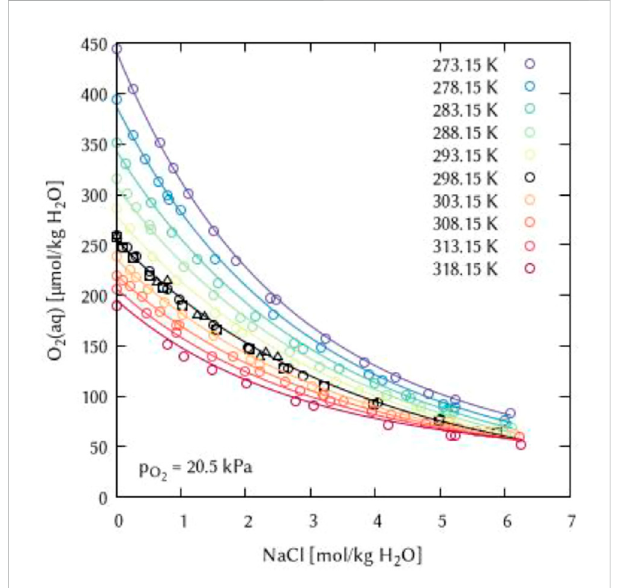
FIGURE 11 Modelling of the O 2 solubility in potassium chloride solution as a function of temperature and KCl concentration. (Points: Experimental data from □ Millero et al. (2003), Lines: this work).